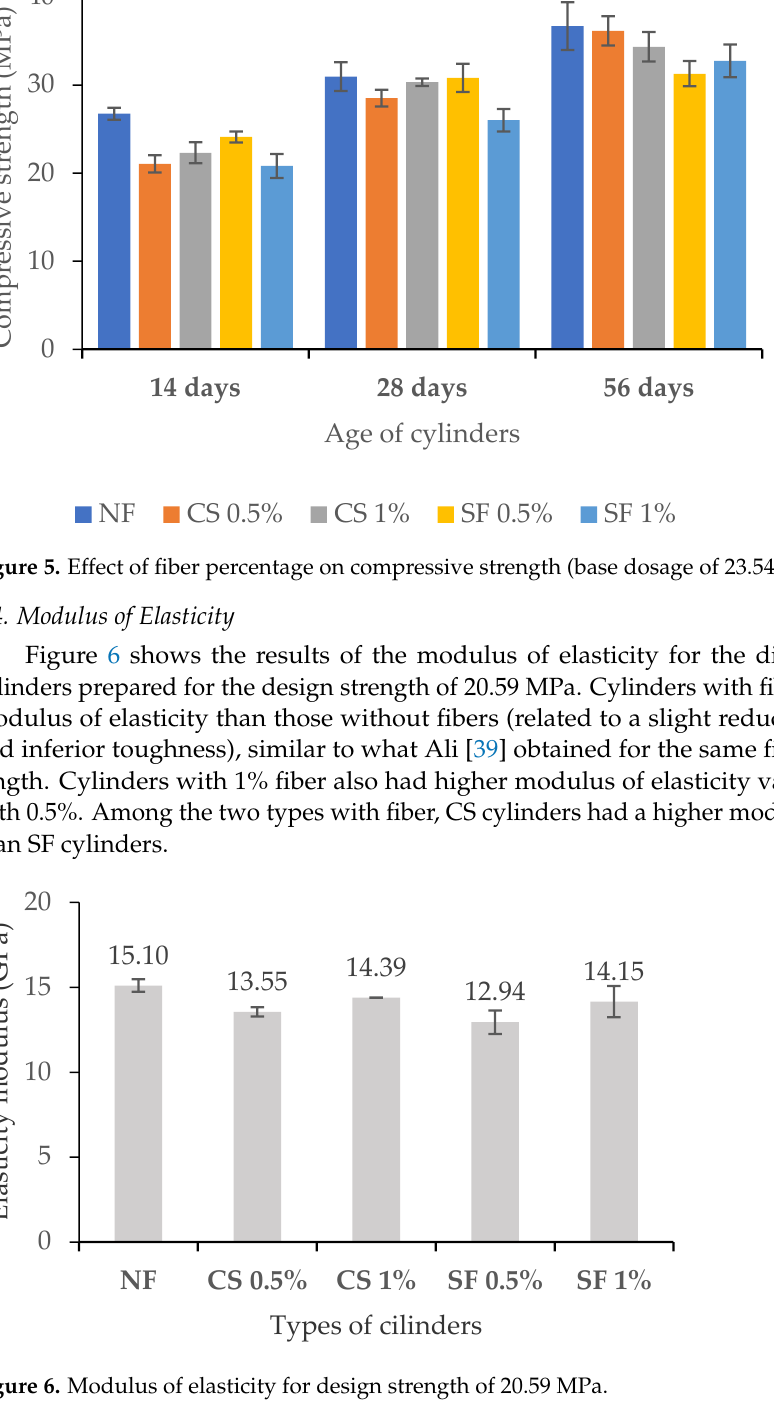
Figure 6. Modulus of elasticity for design strength of 20.59 MPa.